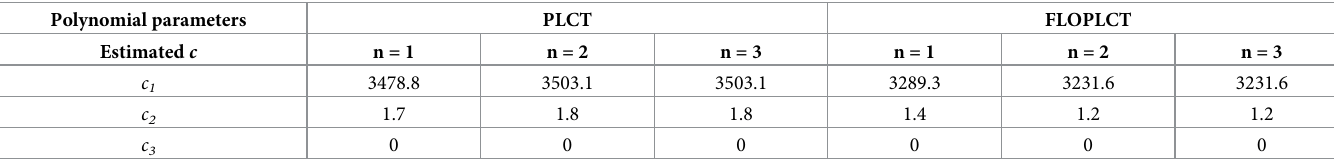
linear function of time. Hence, the improved FLOPLCT is proposed employing a series of mal polynomial chirp rate parameters according to the last time frequency peak of the signal in time frequency domain. when ~ c ¼ c , FLOPLCT degenerates into FLOLCT. We compare Table 4. The estimated polynomial parameters of the bearing ball fault in the position of DE data contaminated by Gaussian noise ( SNR = 5 dB ) employing the PLCT and FLOPLCT methods ( n = 3). Polynomial parameters PLCT FLOPLCT Estimated